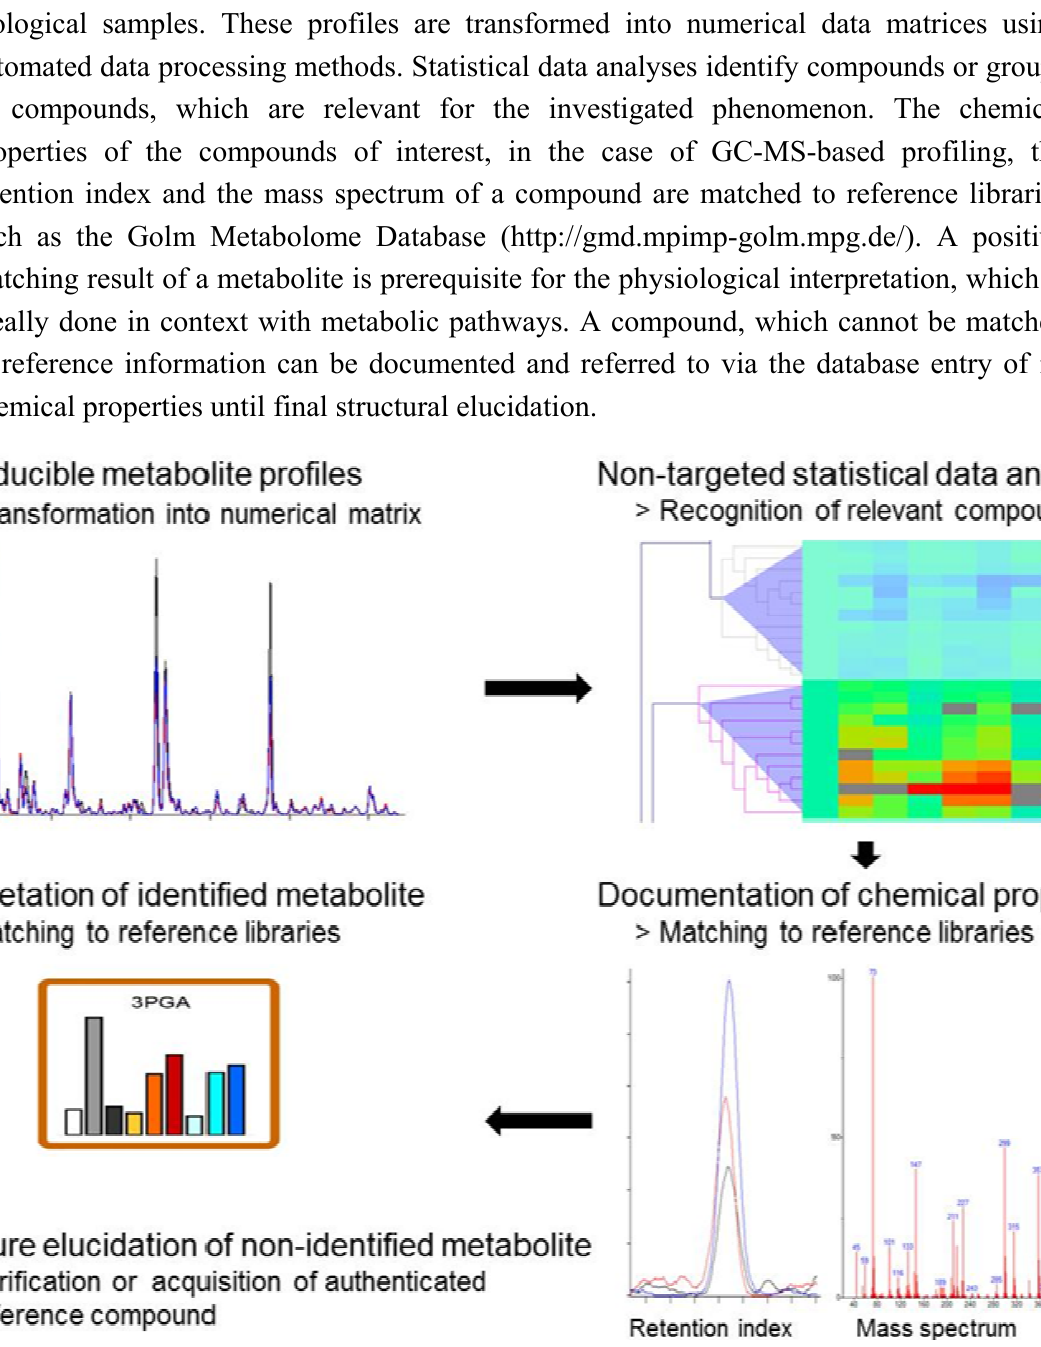
Figure 2. The essential workflow of non-targeted metabolite profiling.